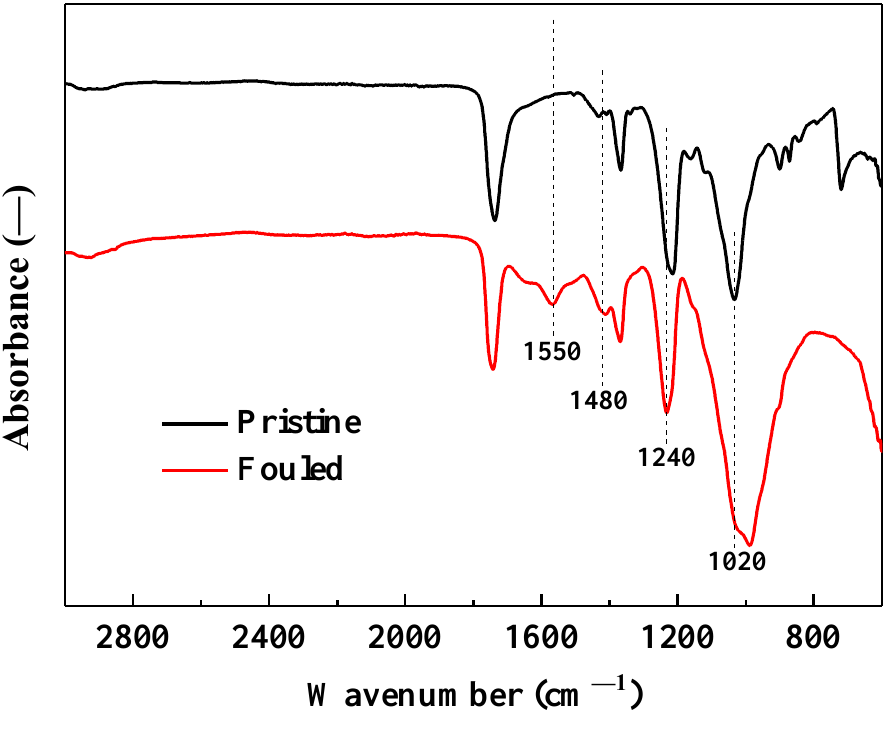
Figure 6. FTIR measurements of the active layer of pristine membrane and fouled membrane after concentrating biogas slurry. The fouled membrane is denoted in Figure 4.